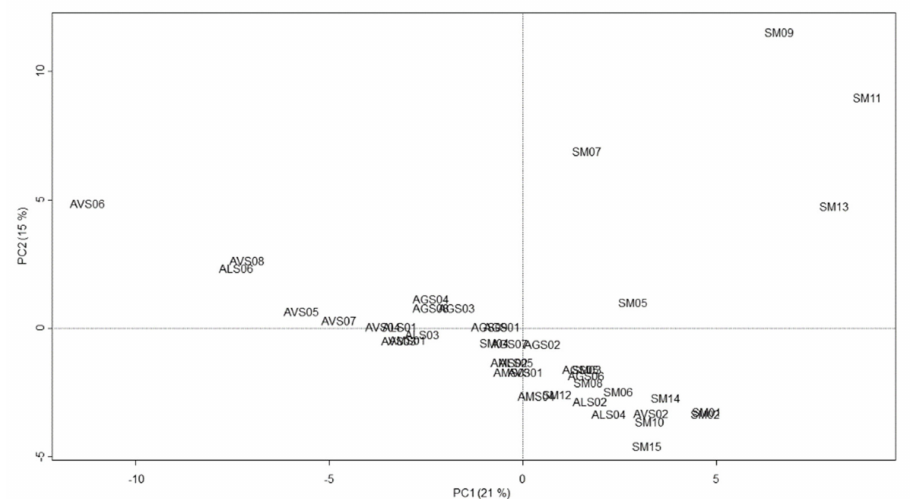
Figure 3. Score plot of principal components (PC1 vs. PC2) on the variables (absolute area of reference peaks) with Amomi Fructus samples. PC1 and PC2 represent 21% and 15% of the total variance, respectively. PC, principal component.